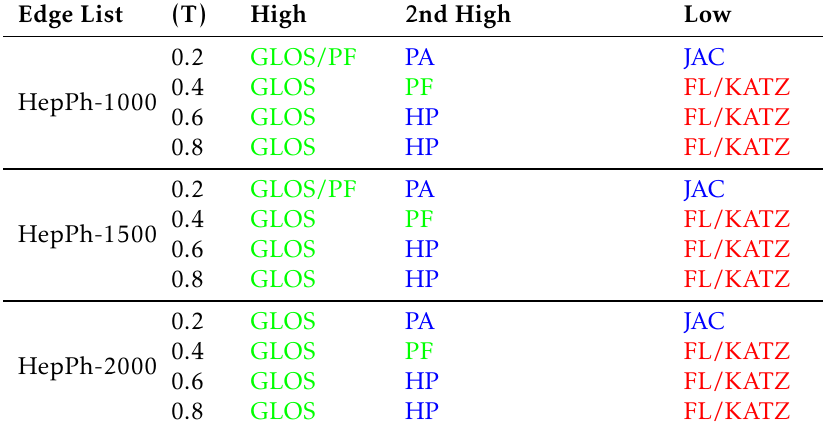
Figure 21 showing the result of third edge list HepTh- 2000 from HepTh dataset. At threshold 0.2, the